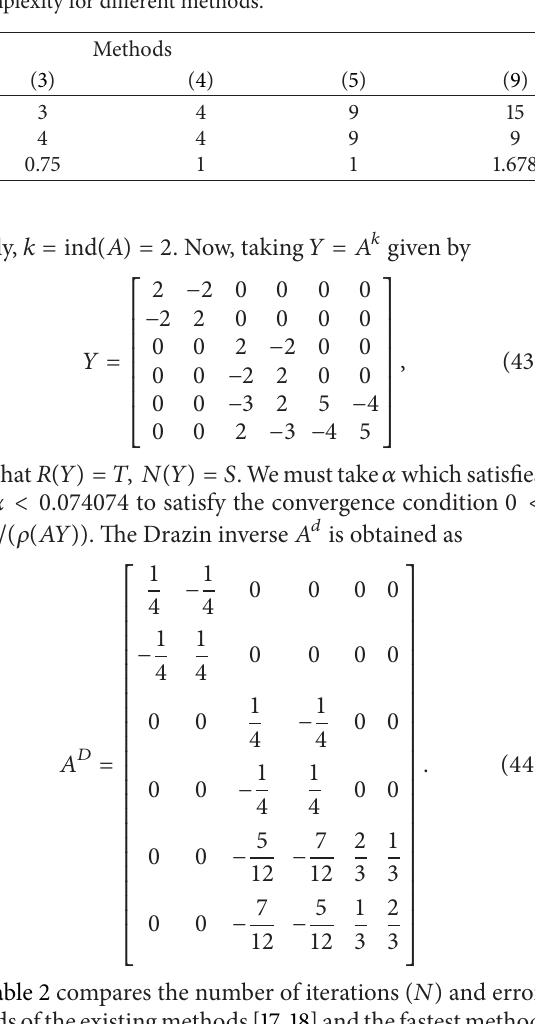
Table 1: Comparison of the computational complexity for different